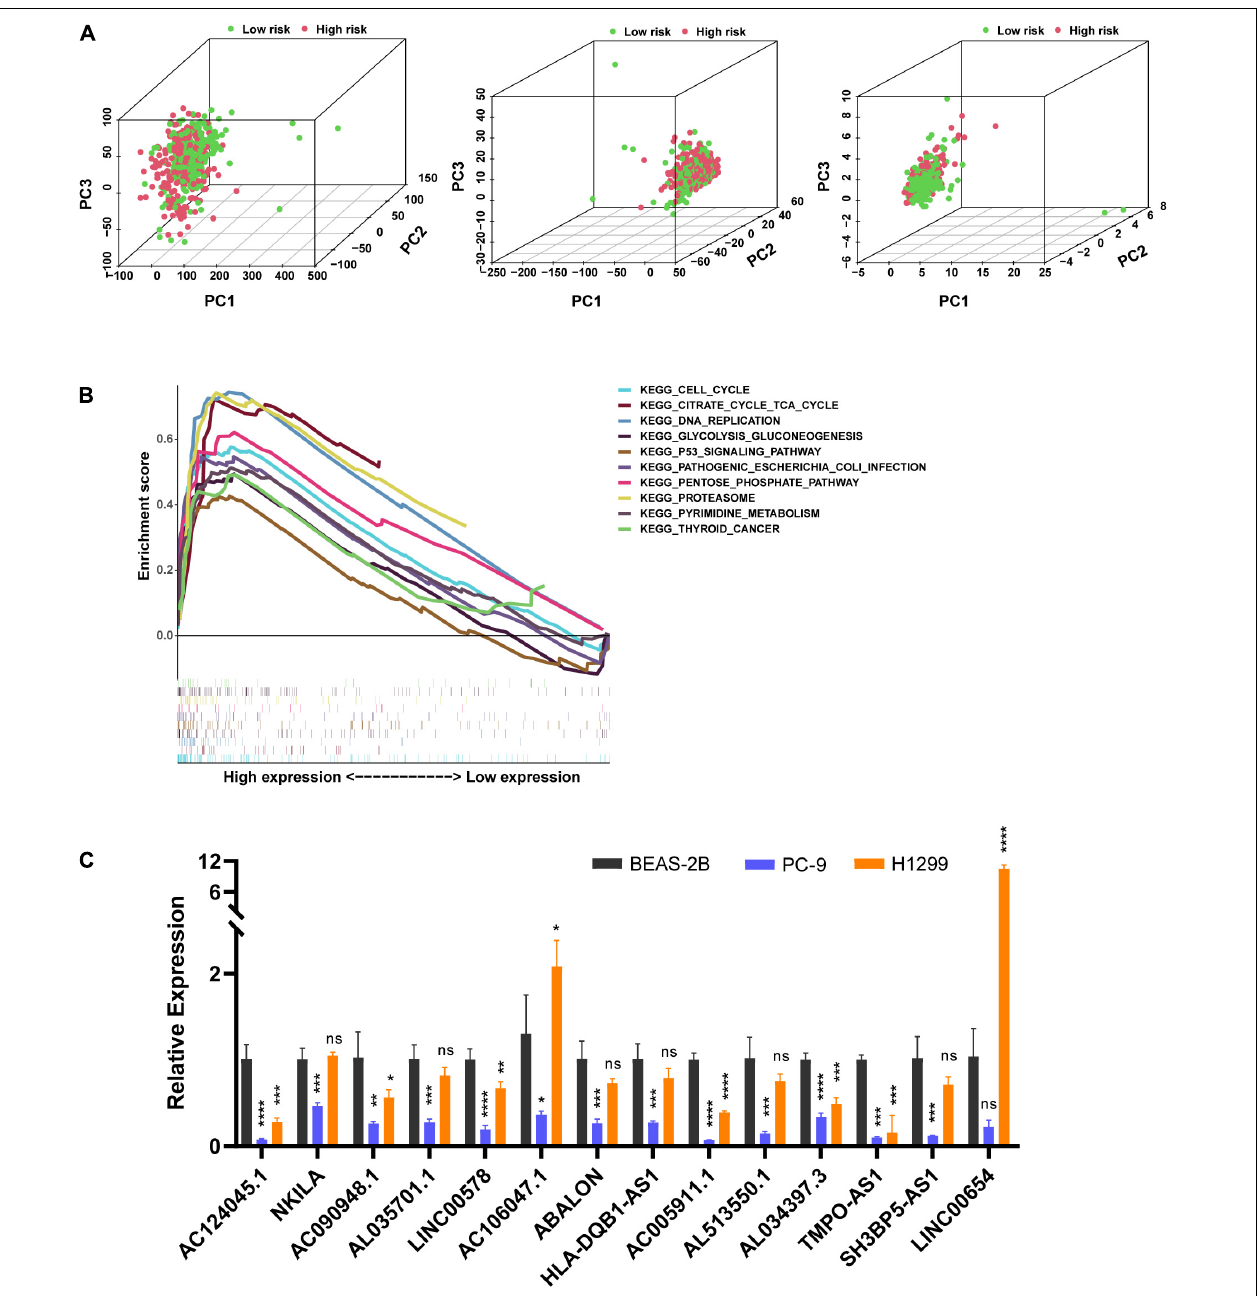
FIGURE 6 | The m5C status was different between the high- and low-risk groups and the expression of m5C-related lncRNAs differed in vitro . (A) Principal component analysis (PCA) was performed for the low- and high-risk groups based on the whole genome and m5C-related coding genes, and a risk model was constructed using 14 m5C-related lncRNAs. (B) Gene set enrichment analysis of m5C-related lncRNAs. (C) Expression level of m5C-related lncRNAs in BEAS-2B cells and LUAD cells. * p < 0.5, ** p < 0.01, *** p < 0.001, and **** p < 0.0001. ns, no